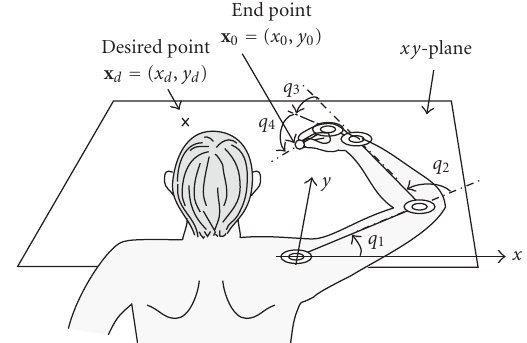
Figure 2: “Reaching” by means of a surplus DOF system of hand- arm